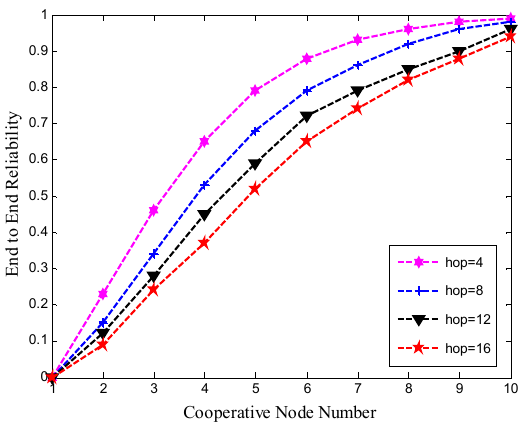
Figure 2. The effect of hops and number of cooperative nodes on end-to-end reliability. Figure 2. The e ff ect of hops and number of cooperative nodes on end-to-end